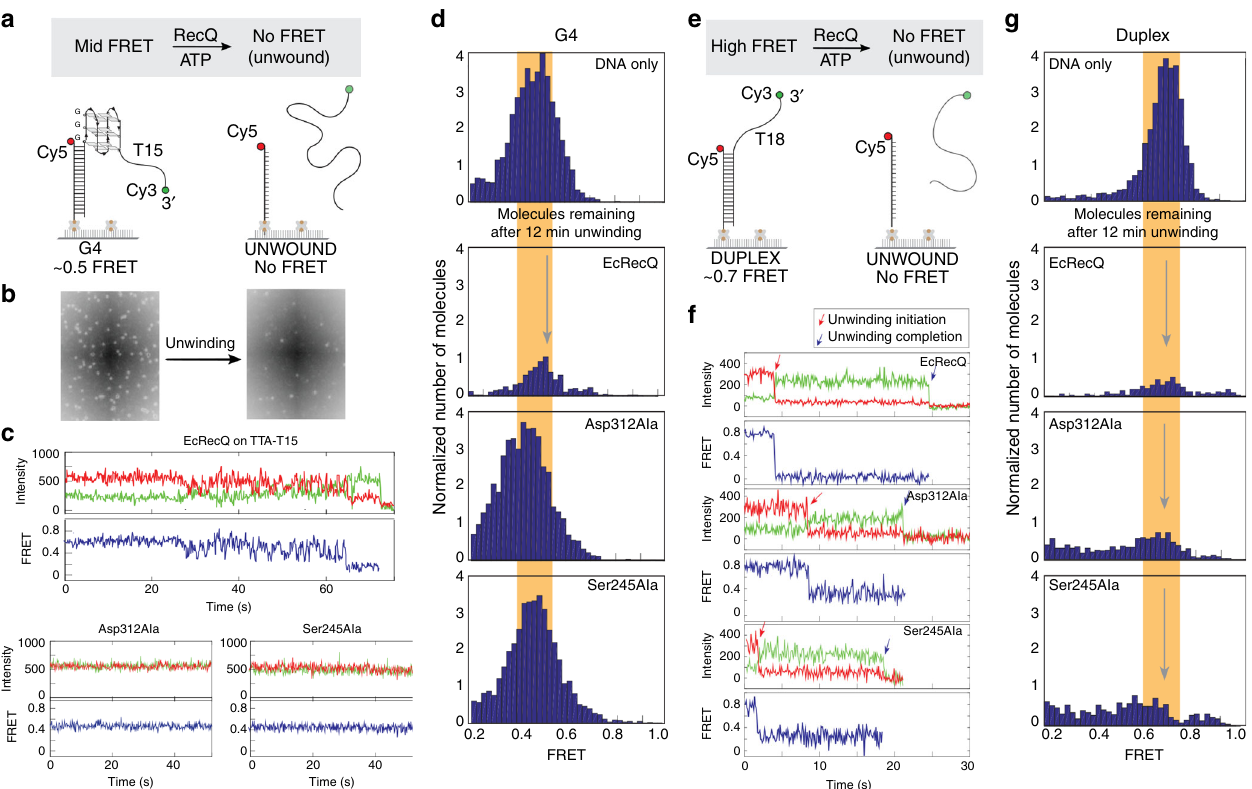
Fig. 2 smFRET studies of RecQ helicase activity. a smFRET strategy to monitor RecQ-mediated unwinding of G4 DNA. b Representative fi eld showing the loss of FRET signal following RecQ unwinding. c Representative smFRET traces of EcRecQ and the RecQ GSP variants on G4 DNA. The top traces for each RecQ variant represent the tethered Cy5 (red) and annealed Cy3 (green) signal, while the lower blue trace denotes the FRET ef fi ciency. d Histograms of the smFRET signals for ~5000 G4 DNA molecules after a 12-min incubation with the speci fi ed RecQ variant. The orange bar and gray arrow denotes the primary FRET peak. e smFRET strategy to monitor RecQ-mediated unwinding of duplex DNA. f Representative smFRET traces of the action of EcRecQ and the RecQ GSP variants on the duplex DNA substrate. Traces are colored as in c . g Histograms of the smFRET signals for ~5000 duplex DNA molecules after a 12-min incubation with the speci fi ed RecQ variant. The orange bar denotes the primary FRET